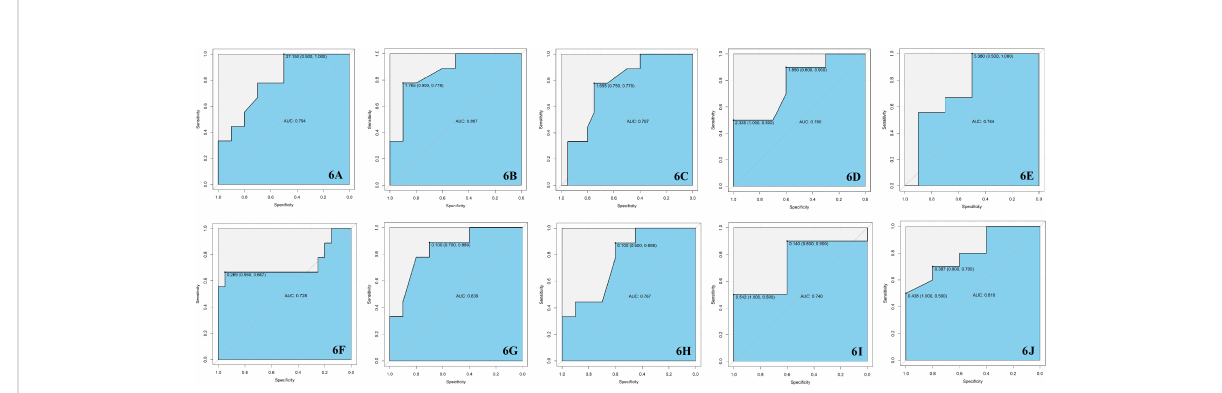
FIGURE 6 (A) The serum level of Cit in T2DM group was higher than NPDR group with the AUC = 0.794. (B) The serum level of IAA in T2DM group was lower than NPDR group with the AUC = 0.867. (C) The serum level of IAA in T2DM group was lower than DR group with the AUC = 0.767. (D) The serum level of IAA in NPDR group was higher than PDR group with the AUC = 0.780. (E) The serum level of 1-MH in T2DM group was lower than PDR group with the AUC = 0.744. (F) The serum level of 1-MH in T2DM group was lower than DR group with the AUC = 0.728. (G) The serum level of hexanoylcarnitine in T2DM group was higher than NPDR group with the AUC = 0.839. (H) The serum level of hexanoylcarnitine in T2DM group was higher than DR group with the AUC = 0.767. (I) The serum level of CDCA in NPDR group was higher than PDR group with the AUC = 0.740. (J) The serum level of EPA in NPDR group was higher than PDR group with the AUC = 0.810. AUC, area under the curve; T2DM, type 2 diabetes mellitus; DR, diabetic retinopathy; NPDR, non-proliferative diabetic retinopathy; PDR, proliferative diabetic retinopathy; Cit, L-Citrulline; IAA, Indoleacetic acid;